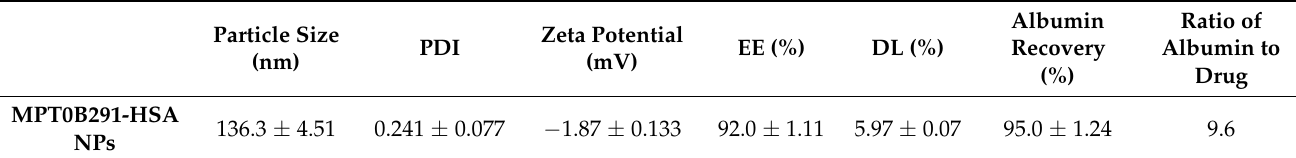
Table 1. Characterization of MPT0B291-loaded human serum albumin (HSA) nanoparticles (NPs). Each point represents the mean ± SD. Error bars represent the standard deviation ( n = 3).